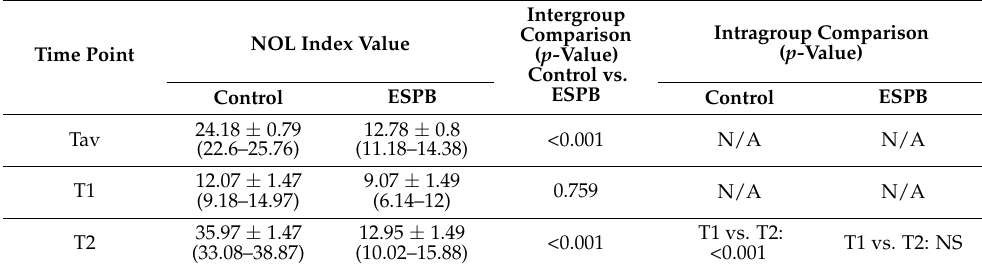
Table 2. Intergroup and intragroup comparison of the NOL index time course.